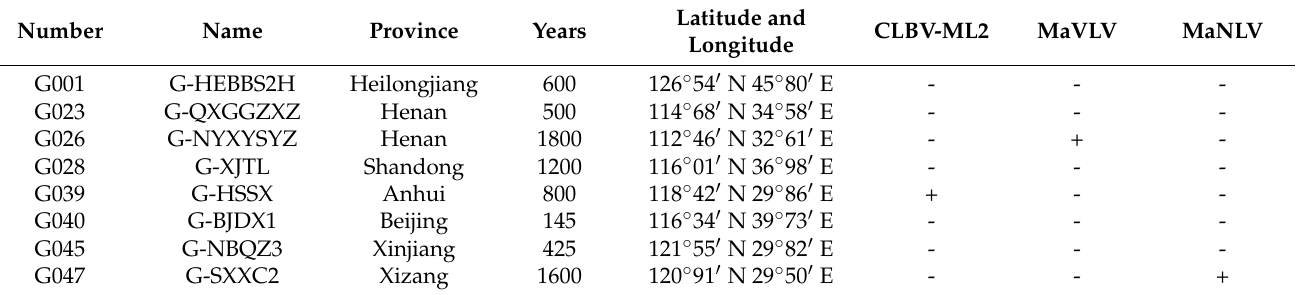
Table 1. Mulberry leaf sample